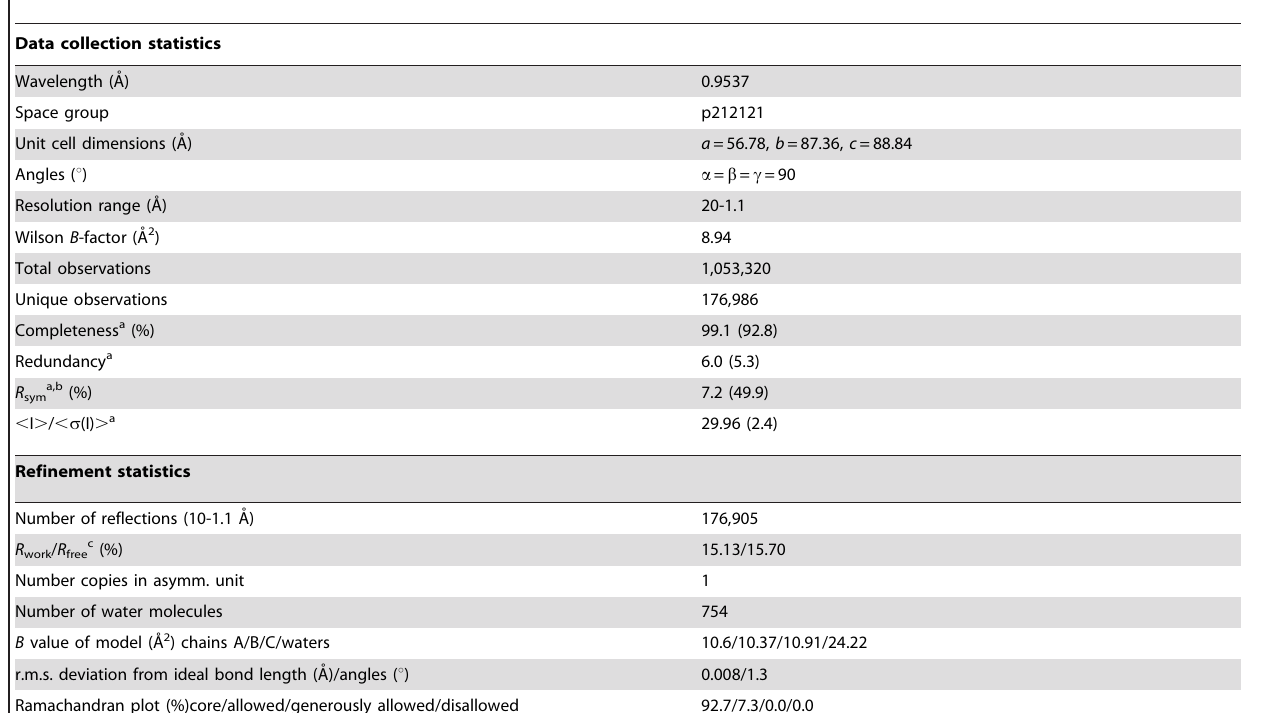
Table 1. Crystallographic data collection and refinement